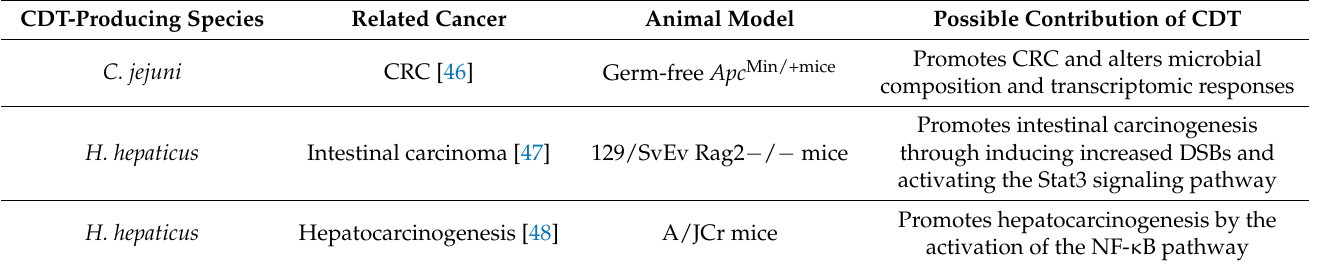
Table 1. The relationships between CDT-producing bacterial pathogens and